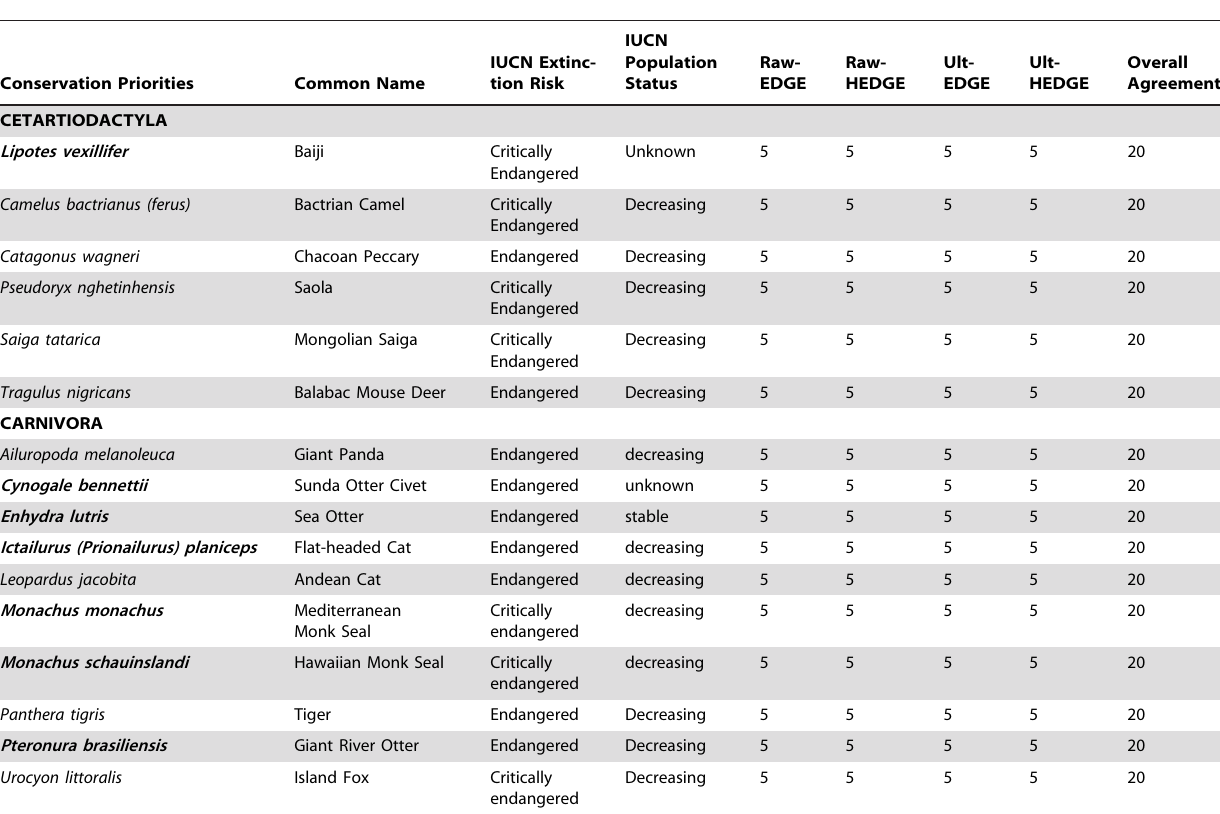
Table 3. Top cetartiodactylan and carnivore conservation priority species obtained from the multiple analysis and approaches.